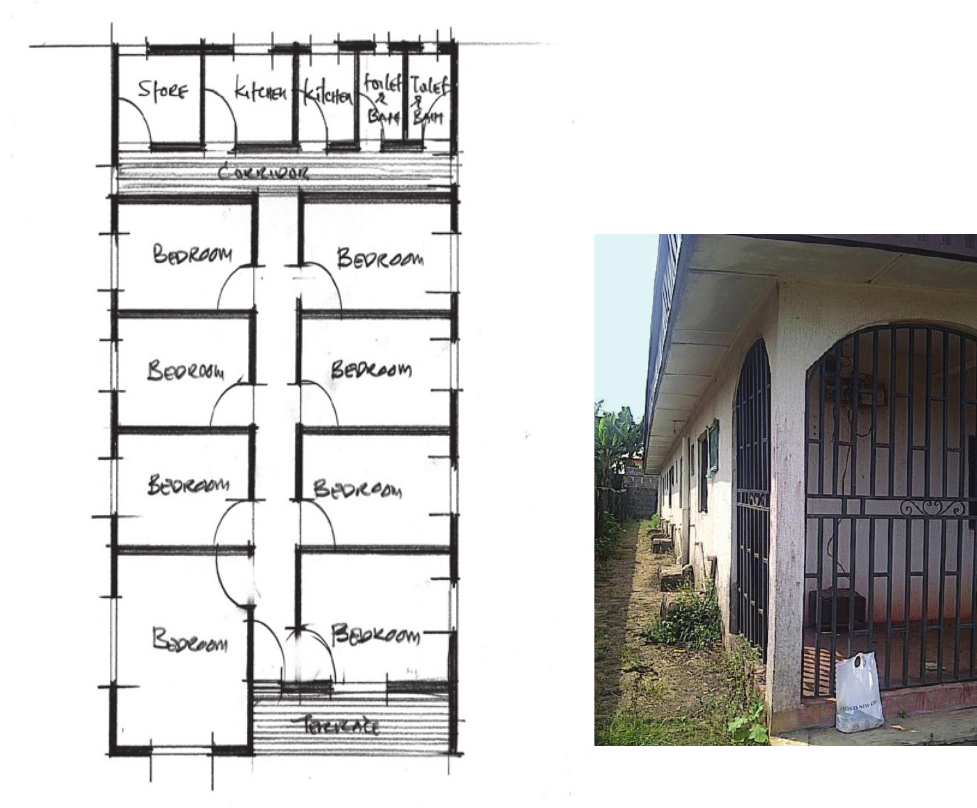
Fig. 8. Floor plan and picture of a typical face me i face you” corridor house-type Source: Ekhaese